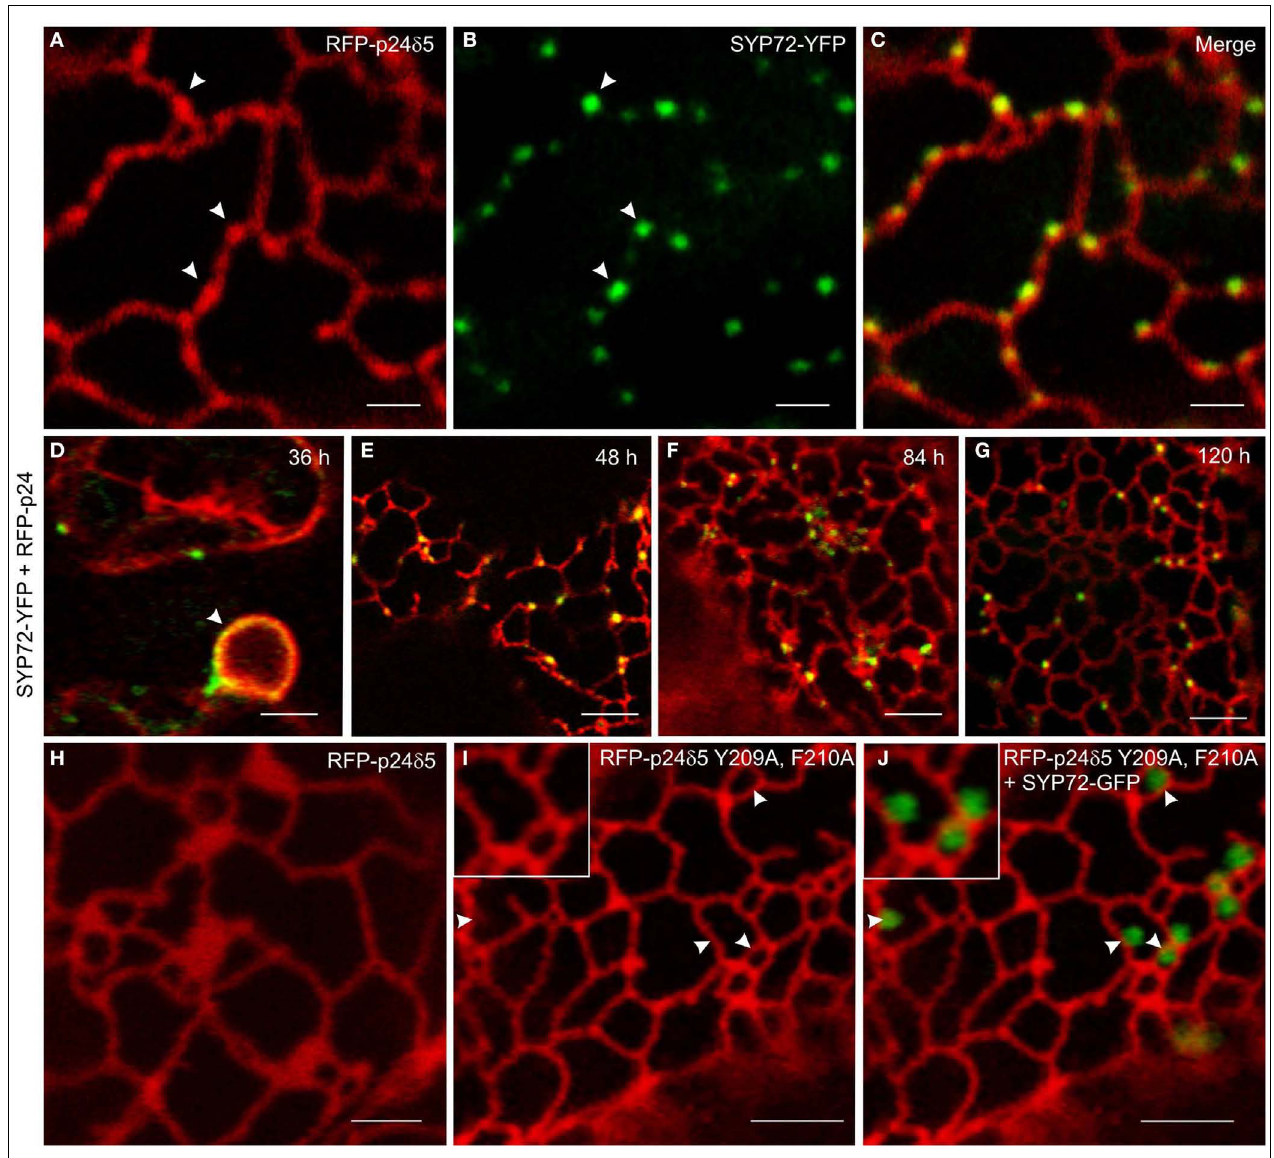
120h post-infiltration. For images (A–G) , theYFP signal is presented in green for easier viewing. (H–J) Coexpression of SYP72-GFP with a mutant form of RFP-p24 δ 5 (which cannot be exported out of the ER – see Materials and Methods) in tobacco leaf epidermal cells. As with leaf cells expressing only RFP-p24 δ 5, nodules in the ER tubular network are not present [compare (H) with (I) ], and the SYP72-GFP punctate signals are distributed randomly on the surface of the ER (J) . Magnification bars = 2 µ m (A–C,H) ; 5 µ m (D–G,I,J)